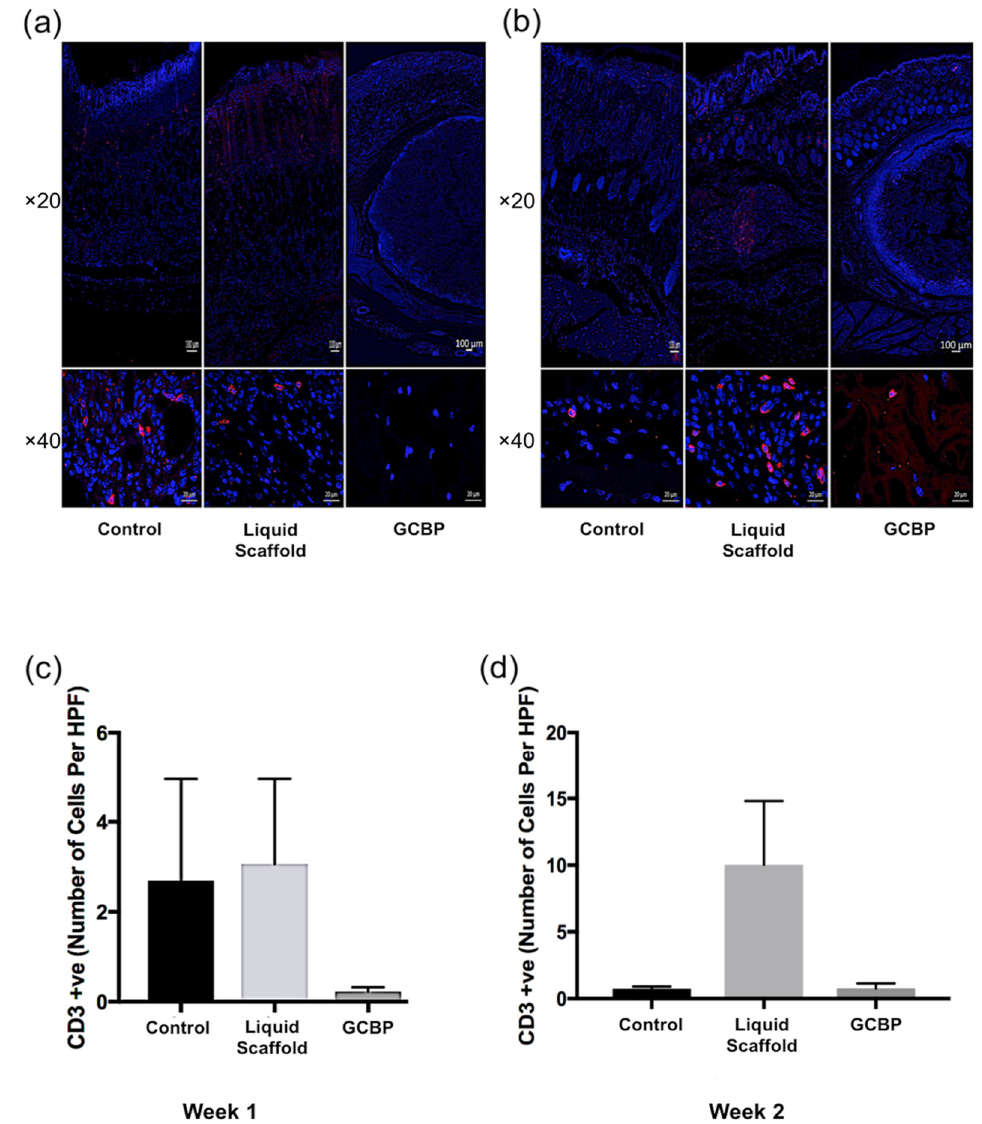
Figure 6. ( a ) Immunofluorescence staining of CD3 ‐ positive cells (red), counterstained with nuclear stain DAPI (blue) after 1 week. ( b ) IF of CD3+ cells after 2 weeks. ( c ) Quantification of CD3+ cells after 1 week. ( d ) Quantification of CD3+ cells after 2 weeks. The number of CD3+ cells was limited and with no significant differences among all groups. Scale bars in top and bottom rows = 100 μ m and 20 μ m, respectively.